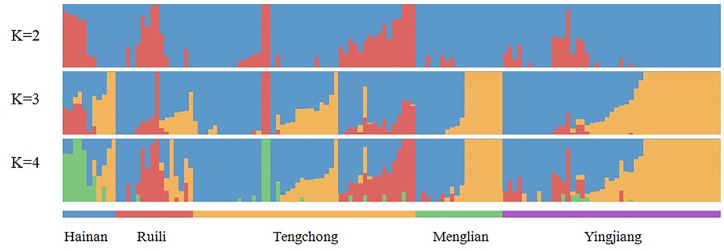
Population structure of the sample set, analyzed on the basis of geography, using ADMIXTURE. Parasites from the different sites in Yunnan Province along the border areas and Hainan Province were slightly separated.